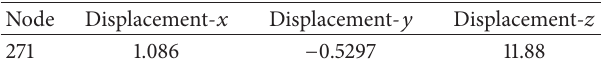
Table 7: The displacements (in m) at green nodes using the linear FEM for the fourth experiment. The displacements at blue nodes are zero.